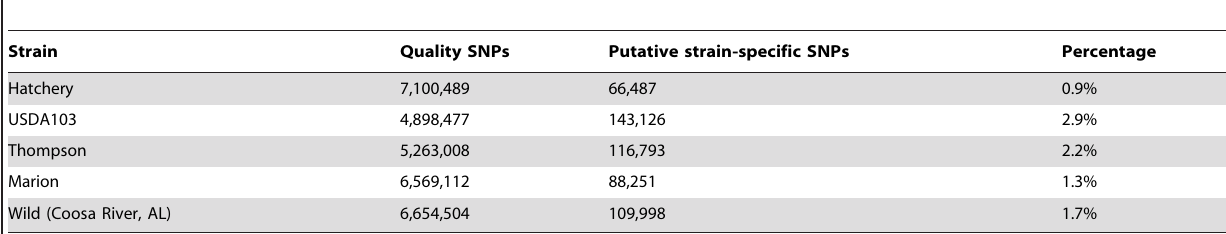
Table 4. Summary of strain-SNPs in channel catfish, including quality SNPs in the strain, strain-specific SNPs and the percentage of strain-specific SNPs.